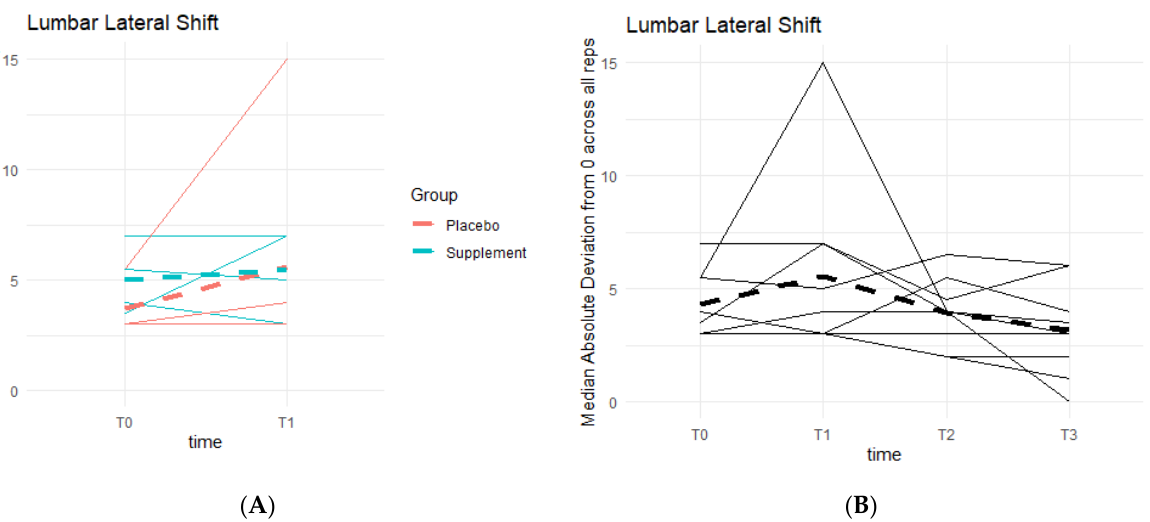
Figure 13. Squat Lateral Shift Deviations. Lateral shift deviations were recorded. The median absolute deviations from 0 degrees across all repetitions as a function of time were then graphed. ( A ) compares Supplement vs. Placebo Groups from T0 to T1. ( B ) shows averages for the entire cohort at T0, T1, T2 and T3.